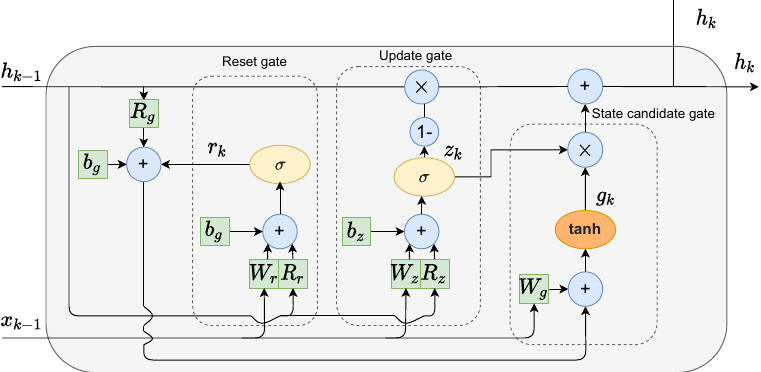
Figure 3. The GRU cell